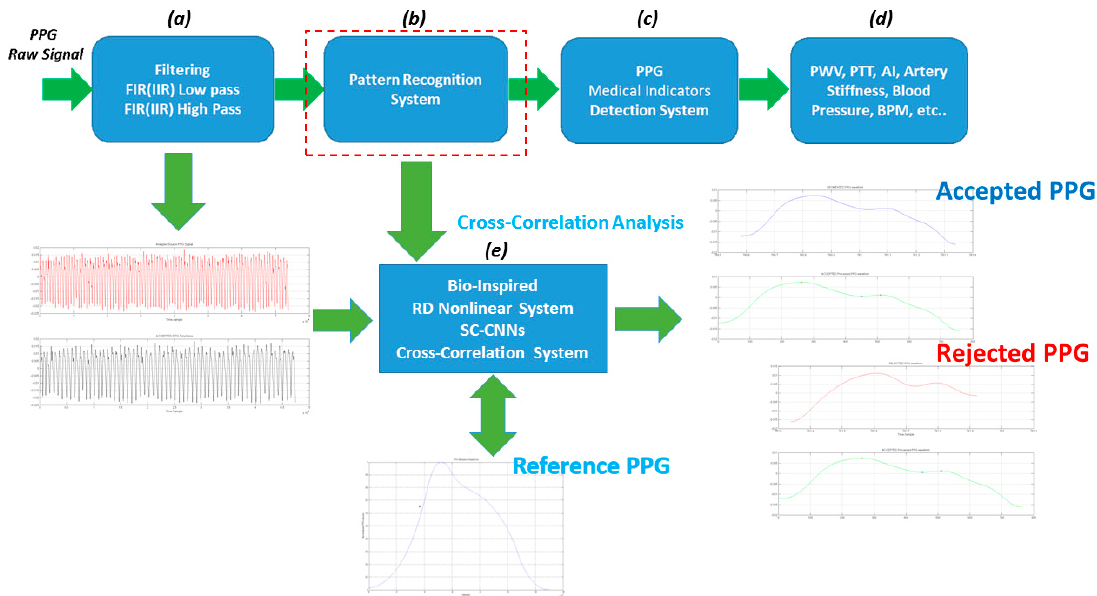
Figure 9. The pipeline is composed by the PPG raw signal filter, consisting of a FIR pass-band scheme ( a ). The second block is the PPG pattern recognition system ( b ), which is followed by the medical indicators detection system ( c ) and the indicators extraction stage ( d ). The Figure also shows a schematic illustration of how the proposed Pattern Recognition System (PRS) works ( e ).